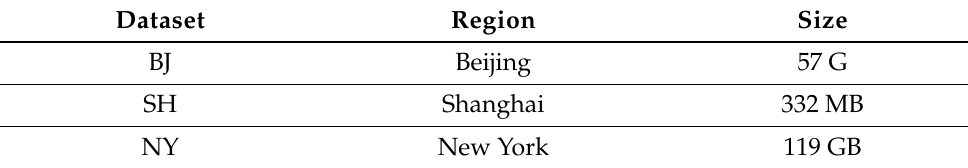
Table 2. Datasets.